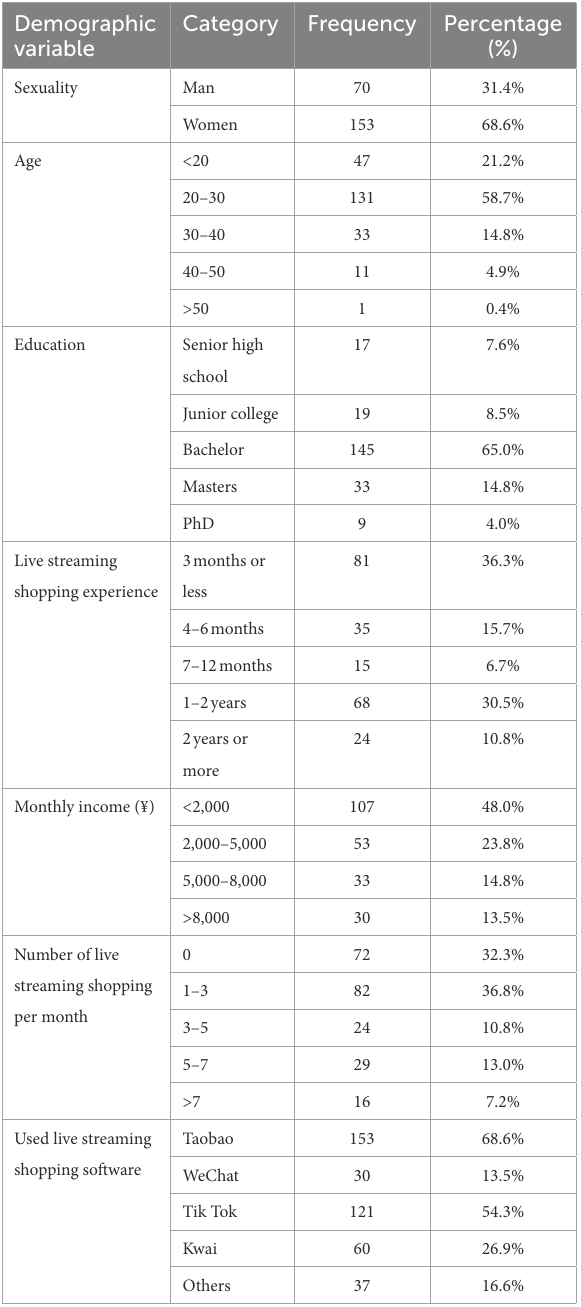
TABLE 2 Sample characteristics